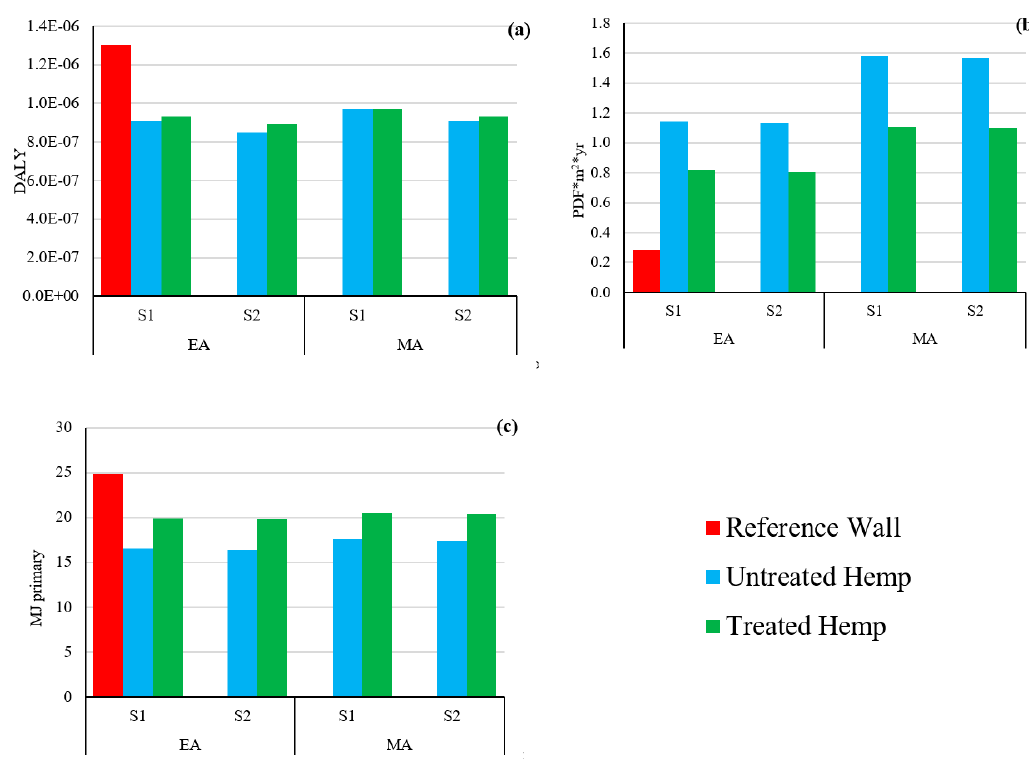
Figure 7. Endpoint environmental impacts of 1 m 2 hempcrete wall compared to cavity wall. ( a ) Human health, ( b ) ecosystem quality, ( c ) resources. EA and MA show the results based on economic and mass allocation, respectively. S1 and S2 are waste scenarios (S1—composting hemp shiv and landfilling the rest, S2—landfilling all the materials).